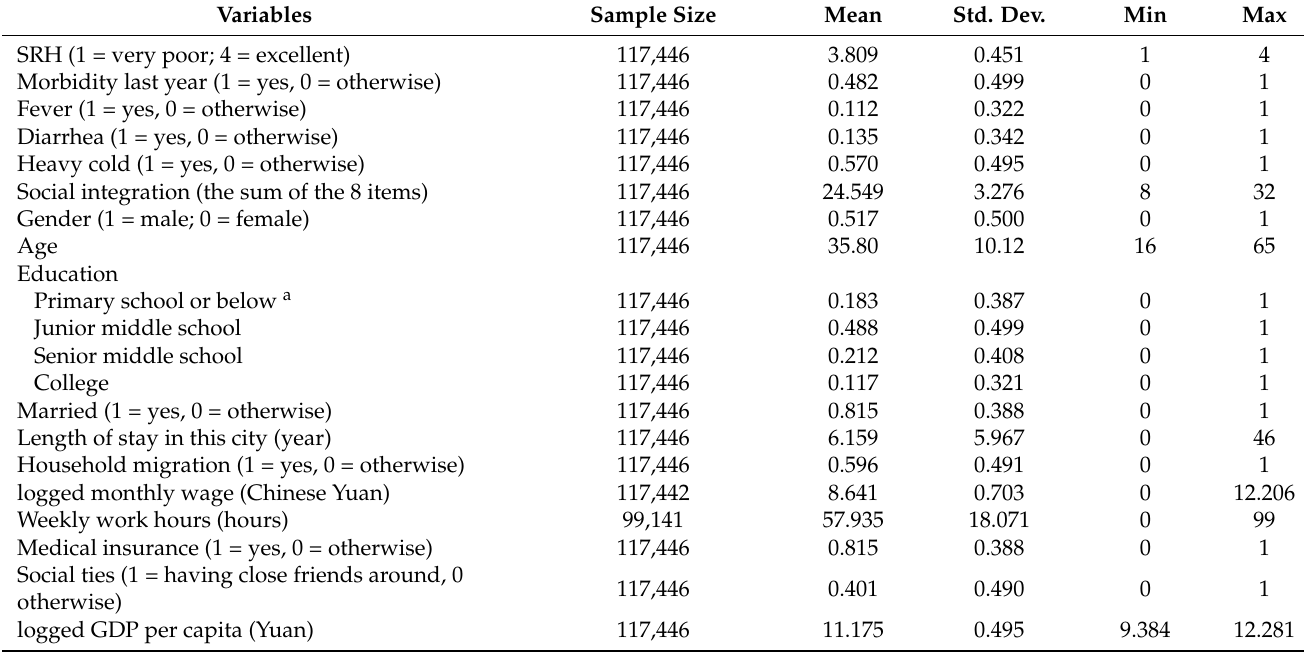
Table A2. Descriptive